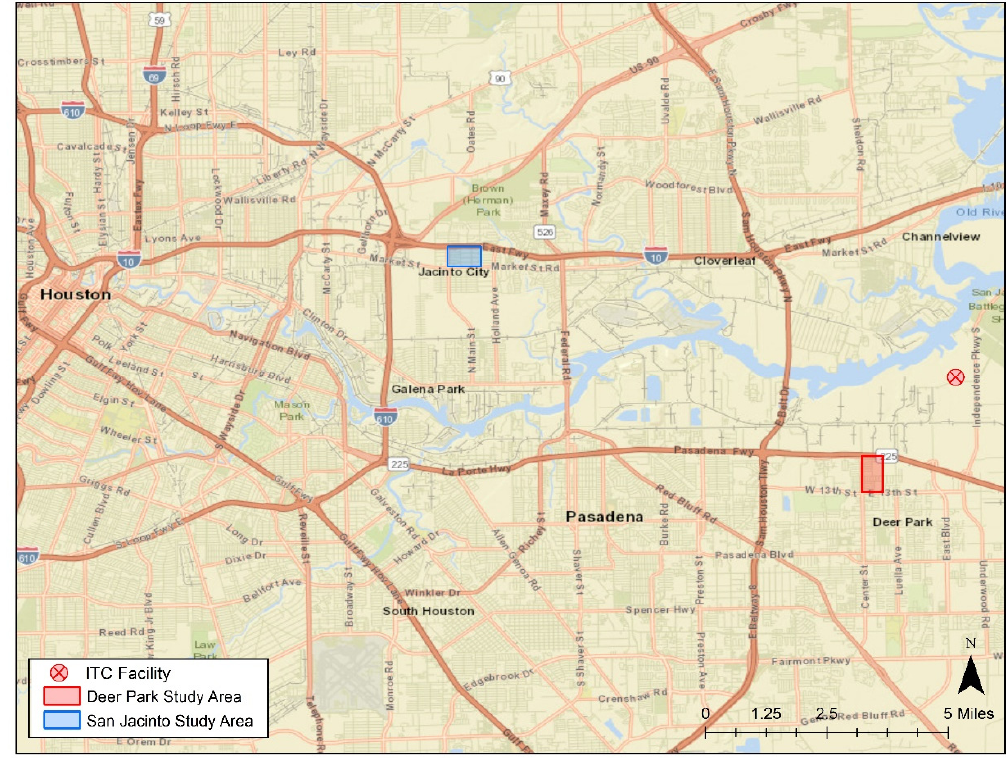
ff ected residential communities monitored during the ITC Figure 2. Two affected residential communities monitored during the ITC fire . Figure 2. Two a